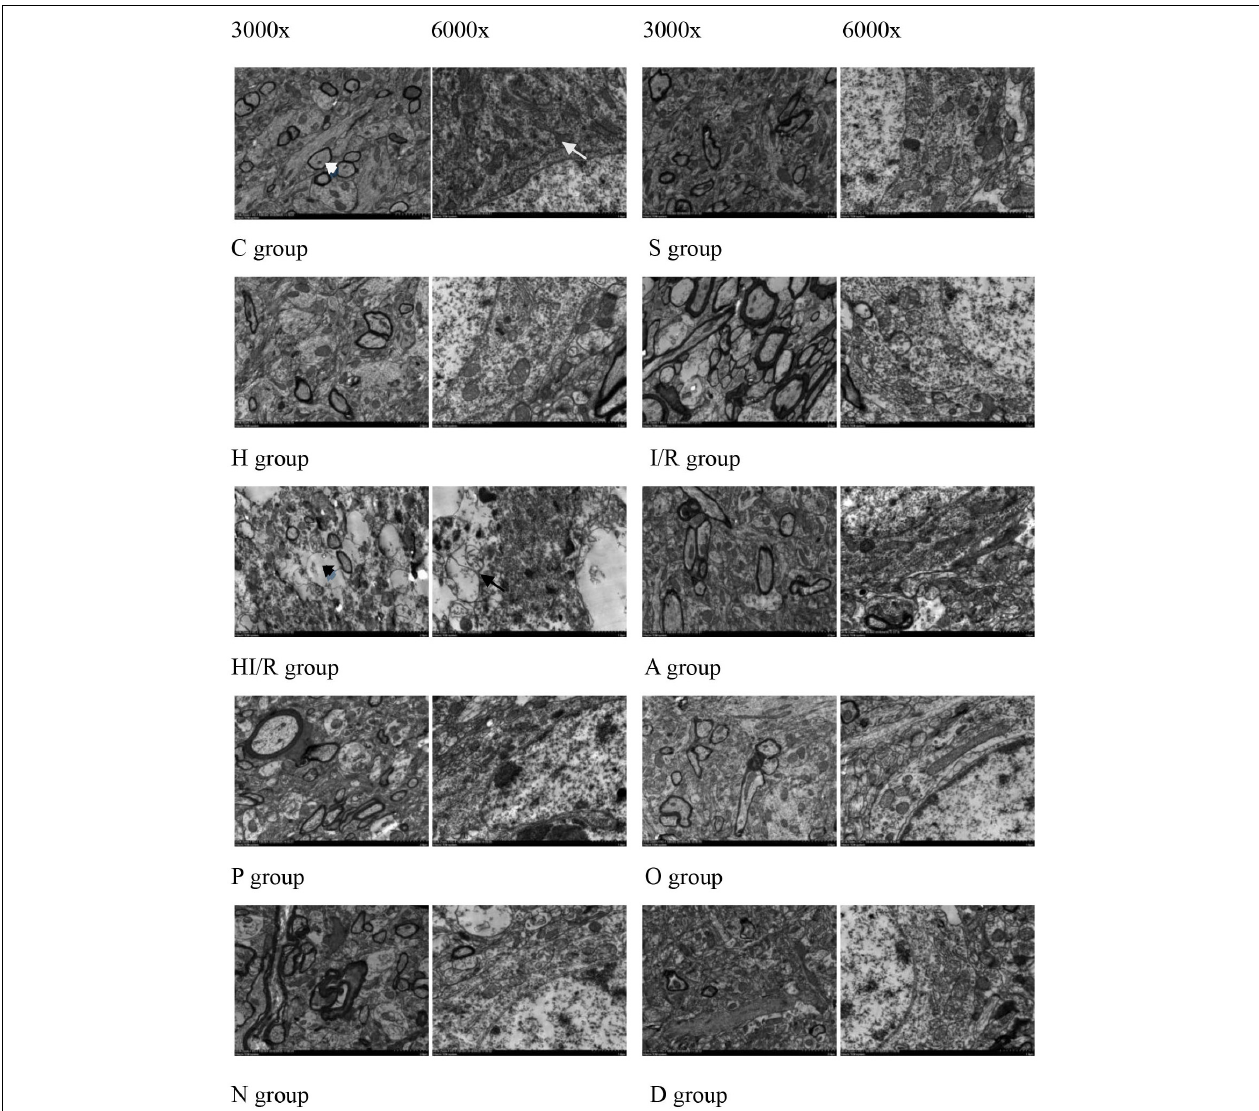
FIGURE 4 | Morphology of cell, myelin sheath, nuclear membrane and mitochondria of brain tissue of the rats 24 h after I/R or not. Abundant round or oval mitochondrial (arrowheads) and clear crista (arrows), myelin sheath and nuclear membrane appeared in the rats of control (C) and sham operated groups (S). Partly impairment of myelin sheath and irregularity of nuclear membrane appeared in H group (H). Myelin sheath destroyed, nuclear membrane disappeared (black arrows), and organelle (black arrowheads) decreased in the rats received I/R, especially I/R combined with HHcy (HI/R). Evident impaired but lesser morphological change in inhibitor groups (A, P, O, N, and